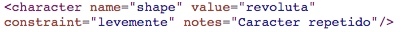
Structured text that exemplifies the use of adverbs in chunk T11L5S7.